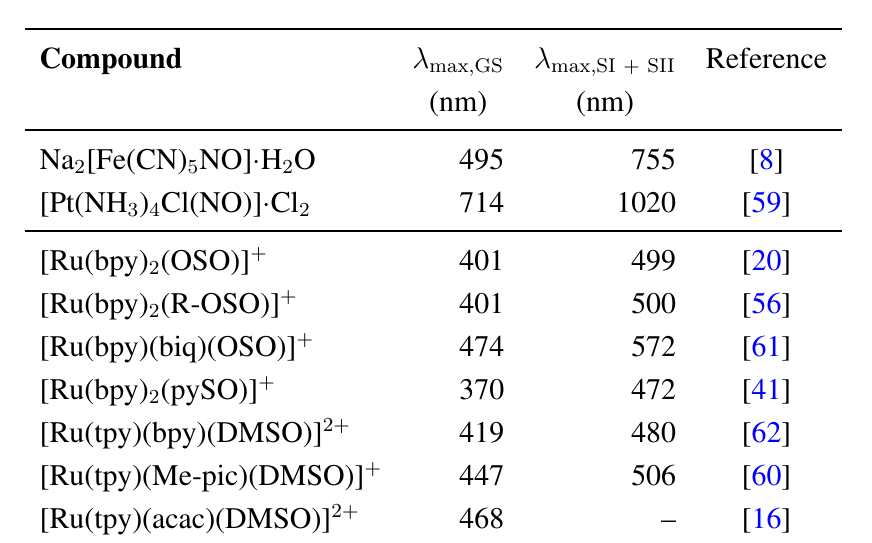
Table 3. Central wavelength of the lowest lying MLCT absorption band in the ground (GS) and metastable states (SI + SII) for selected transition metal